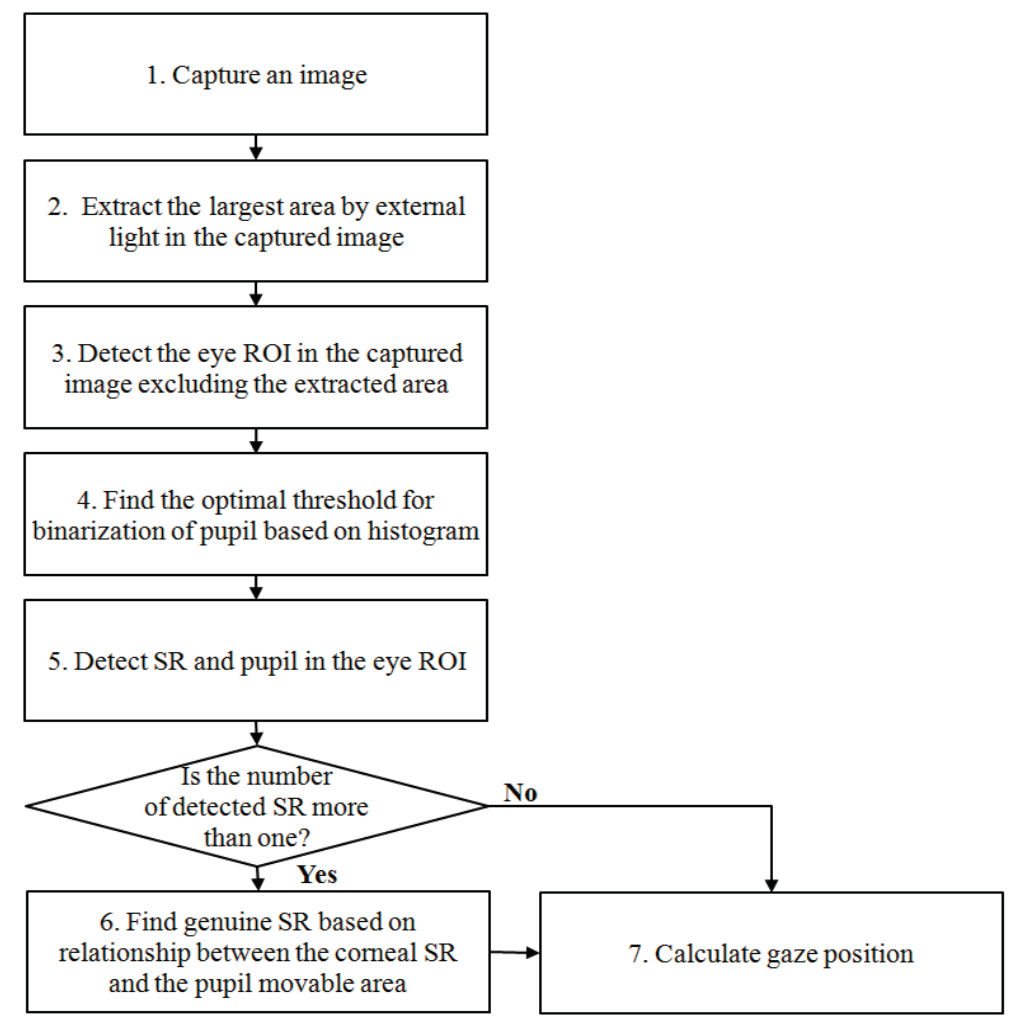
Figure 1. Flowchart of the proposed